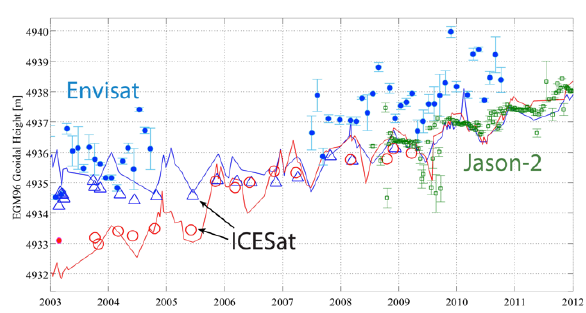
Figure 3. Lake level change measured by TIAS (blue and red solid lines), Envisat, Jason-2 and ICESat.